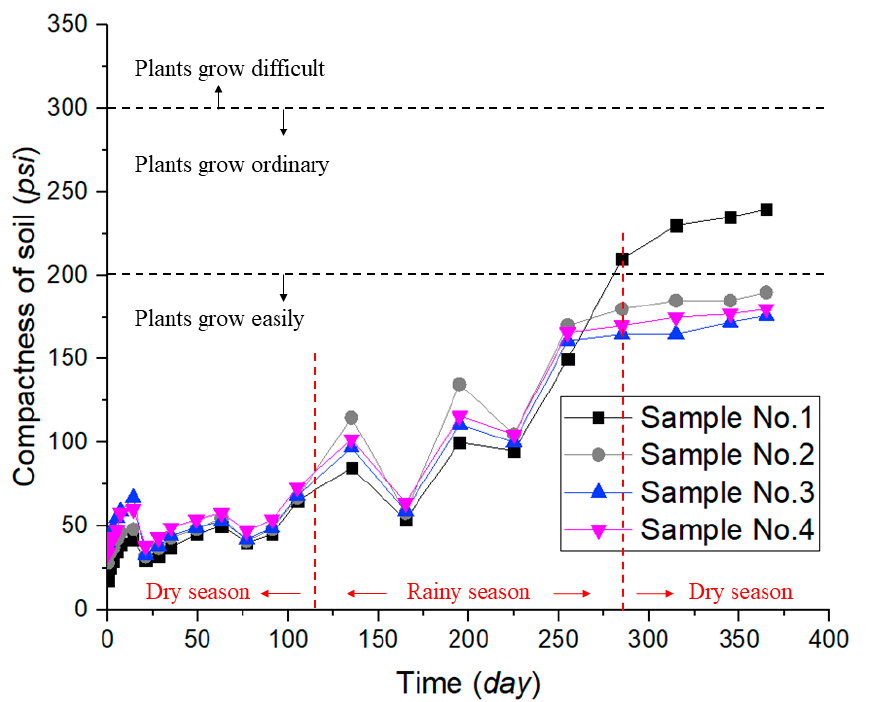
Figure 3. Compactness of soil.